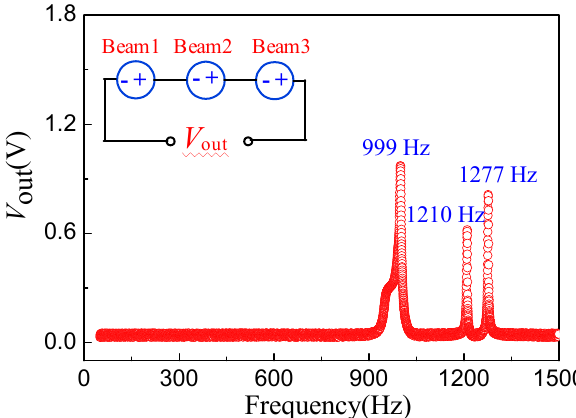
Figure 11. The vibration characteristics of energy harvester series connection.